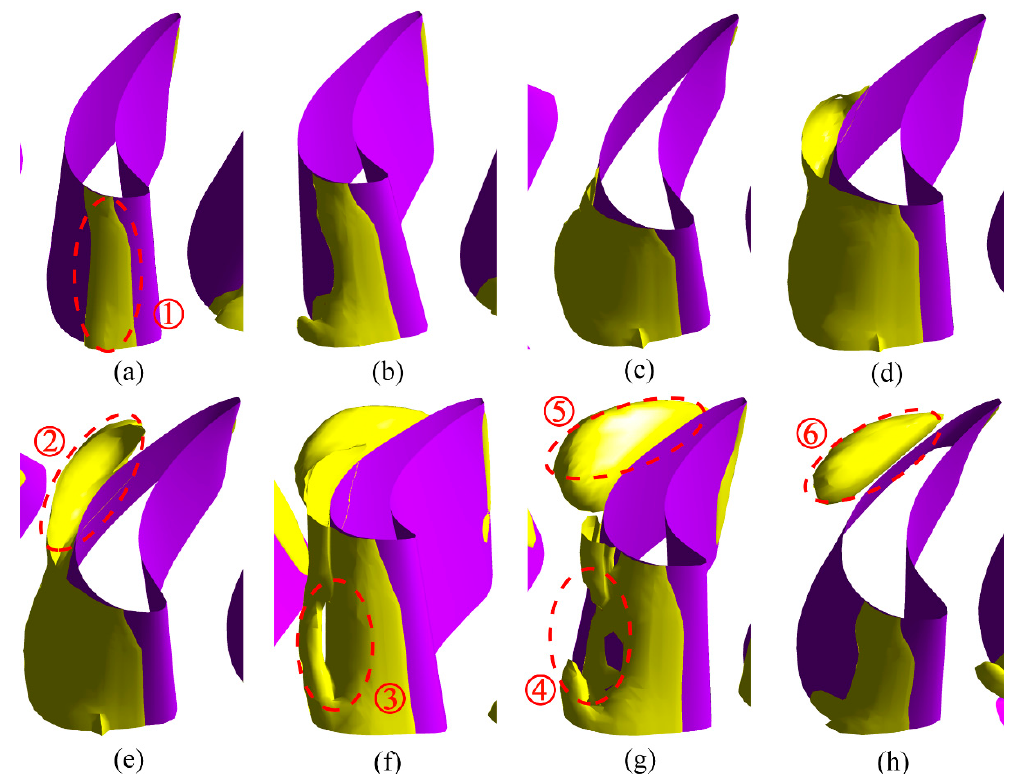
Figure 7. Unsteady cavitation process in the stator domain under SR = 0 condition. ( a ) t = 0.125 T, ( b ) t = 0.25 T, ( c ) t = 0.375 T, ( d ) t = 0.5 T, ( e ) t = 0.625 T, ( f ) t = 0.75 T, ( g ) t = 0.875 T, and ( h ) t = 1 T. (1-attached cavity, 2-cavity development, 3-“O” type cavity, 4-“O” type cavity break, 5-shedding cavity, and 6-scatter cavity (collapse)).